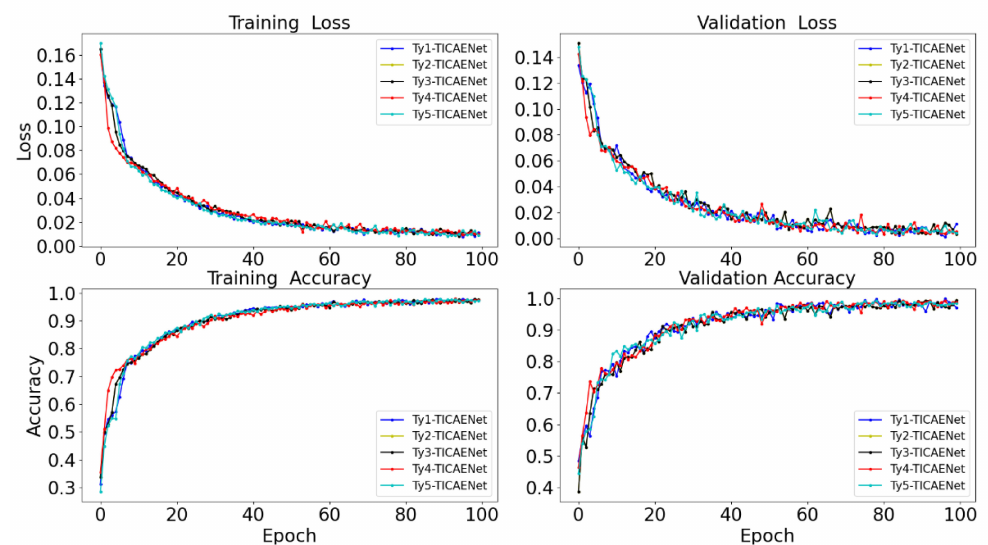
Figure 6. Model training accuracy curves and loss value curves.